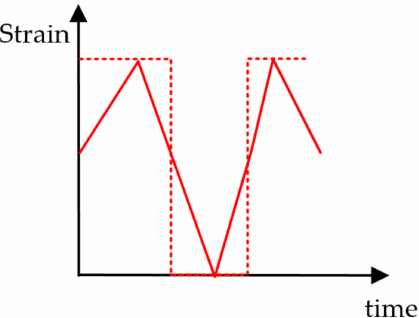
Figure 5. Determination of alternating loads of the sealing bolt.